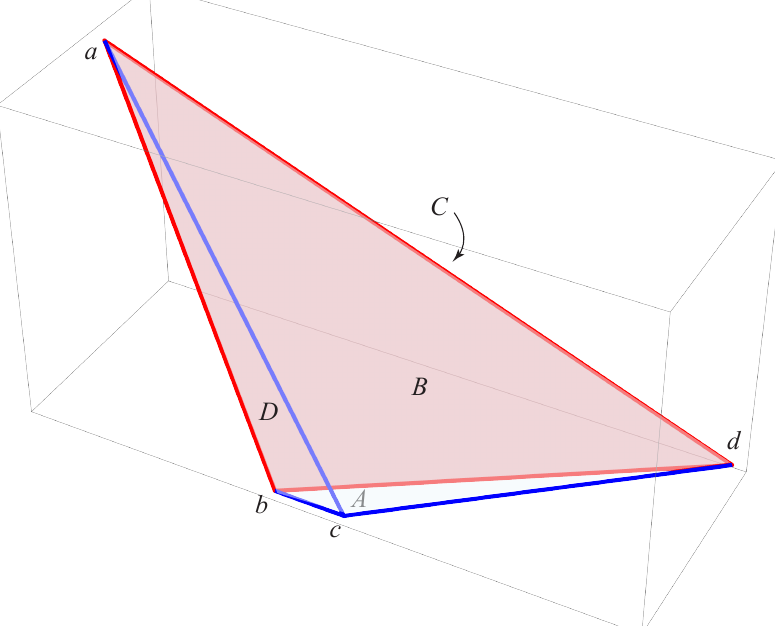
Figure 14. The (red) boundary of shaded back face C = abd is a quasigeodesic, but none of ∂ A , ∂ B , ∂ D are